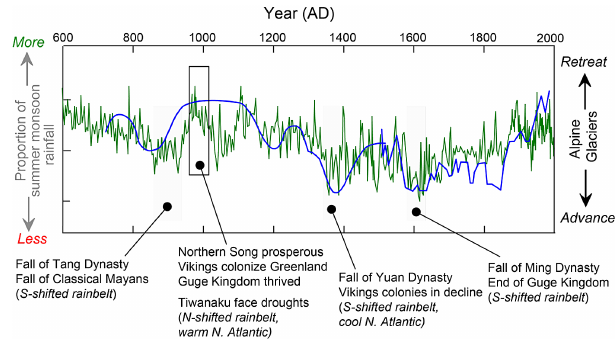
Figure 12. Possible link between climate events and human culture (adapted from Cheng and Edwards, 2012). The Asian summer mon- soon (green, Zhang et al., 2008) tracks the Alpine glacial advance and retreat (blue, Holzhauser et al., 2005), demonstrating that when temperatures were colder in western Europe, conditions were drier in the monsoonal regions of China. The gray bars show some cli- mate events that likely had an influence on human cultural history over the past 2000